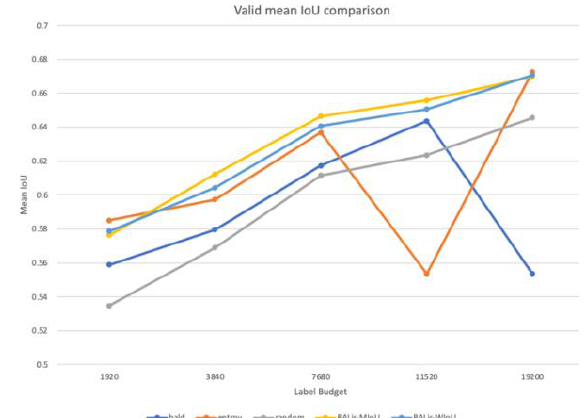
Figure 4. Valid mean IoU score of methods compared across different budgets of labeled